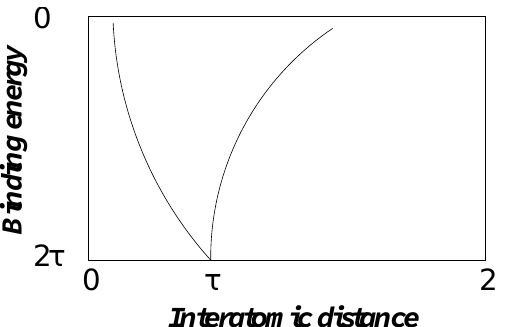
Figure 2. Diatomic covalence curve in dimensionless